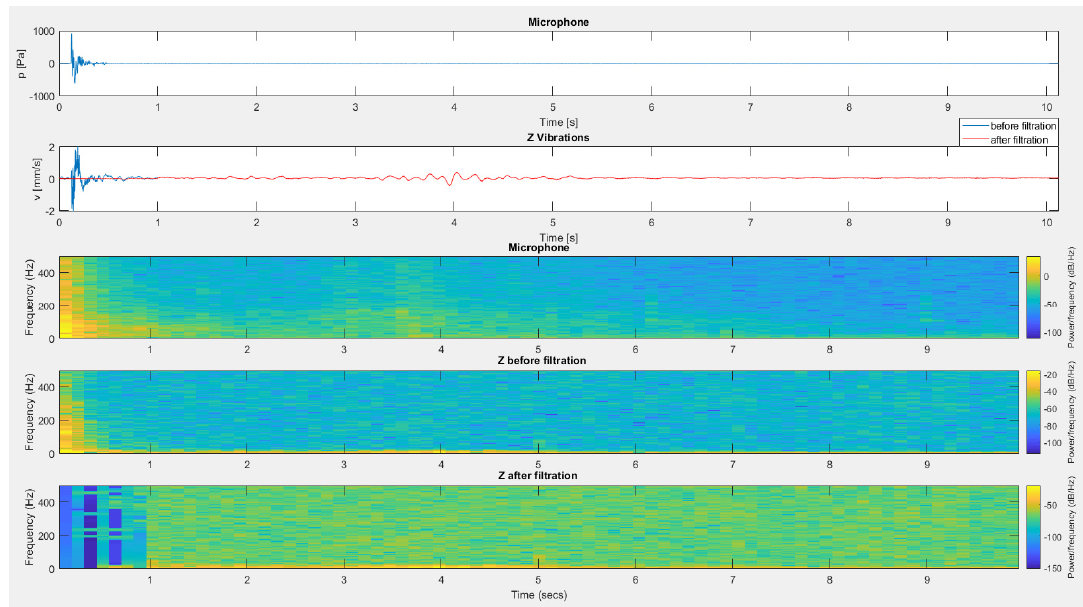
Figure 21. The result of using filtration for the vertical component—testing the fall of a structure to the